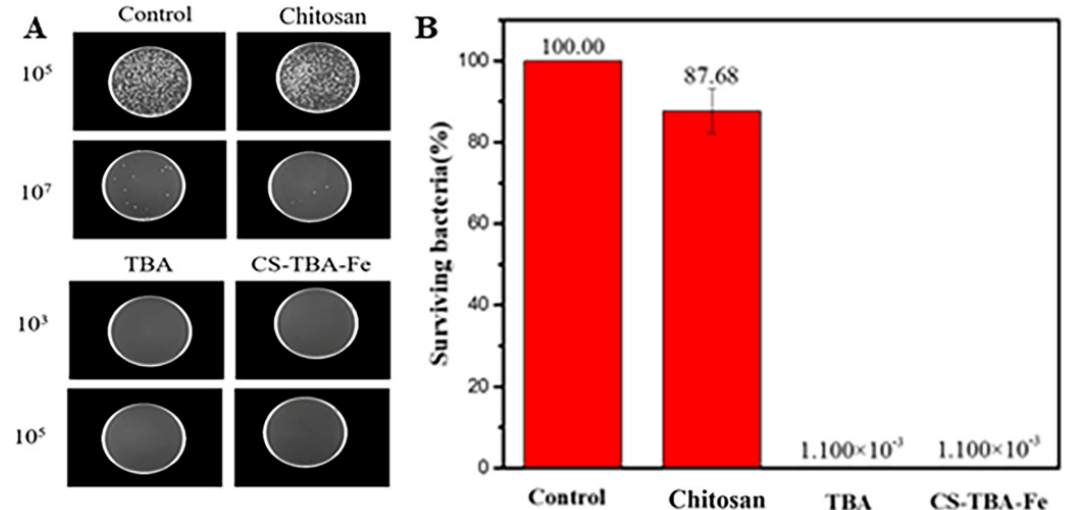
Figure 8. Digital images of surviving bacteria on chitosan, TBA, and CS-TBA-Fe ( A ) samples after being co-cultured with E. coli (A) and comparison of bactericidal activity of chitosan, TBA, and CS-TBA-Fe against E. coli ( B ).